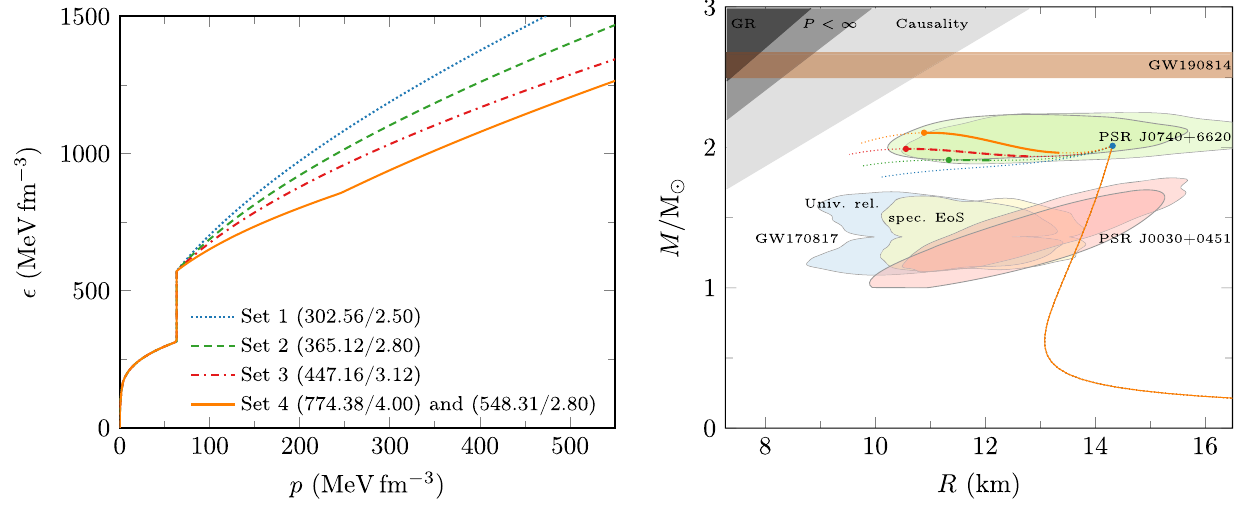
Fig. 2 Left panel: EoSs for the MP model considering four sets of val- ues for the κ and (cid:10) parameters (in parenthesis) that characterize quark matter in the high density regime. As in Ref. [11], for Set 4, we describe the high density regime in terms of two polytrope branches, depending